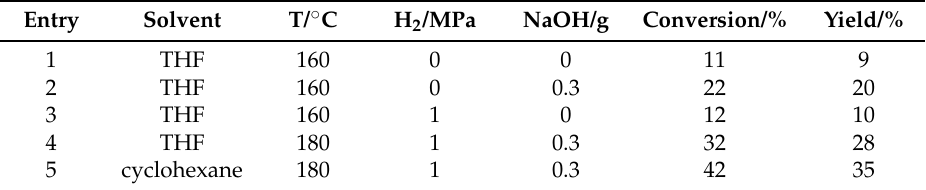
Table 6. Conversion of cyclohexanol into cyclohexylamine over Ni/C in THF and